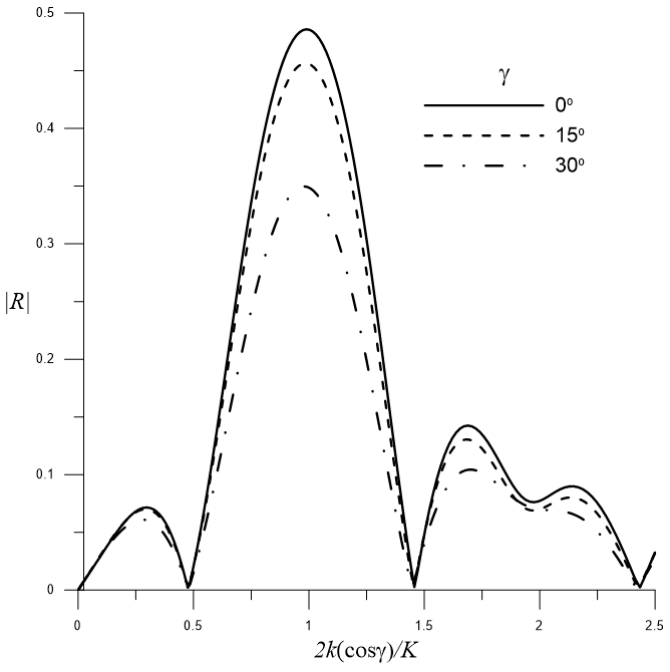
Figure 18. Reflection coefficient | R | varying against 2 k ( cos γ ) / K for the dual ( a ) surface-piercing and ( b ) bottom-standing barriers with different oblique incident angles.